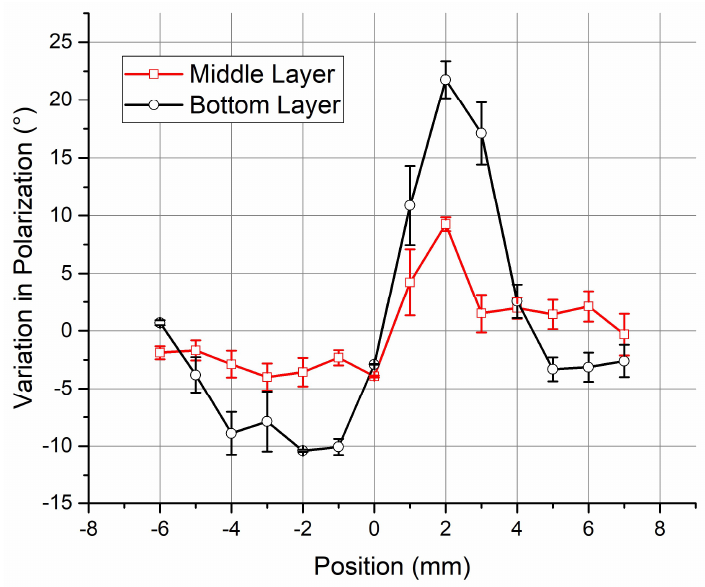
Figure 12. The variation in relative angles between the laser polarization and the RF E-field vector when the laser was passing through different positions of the vapor cell. The red curve (noted as “Middle Layer”) and the blue curve (noted as “Bottom Layer”) are the results of scanning the middle and the bottom of the vapor cell, respectively.